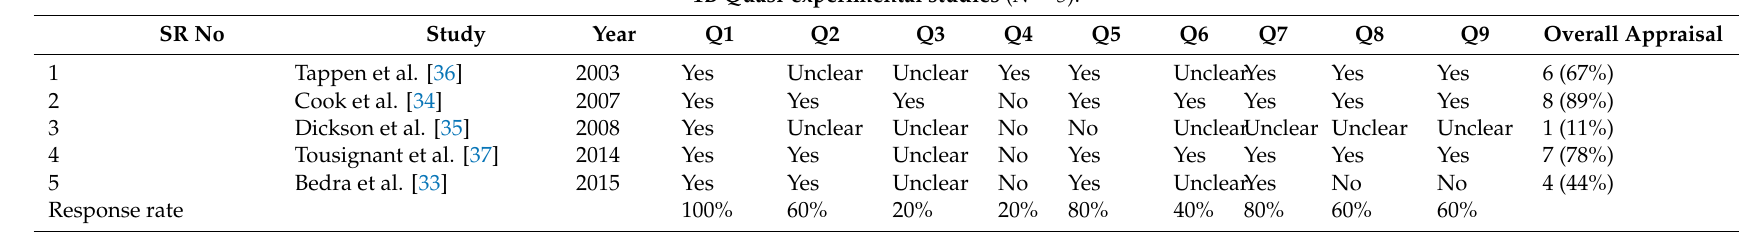
1B Quasi-experimental studies ( N =